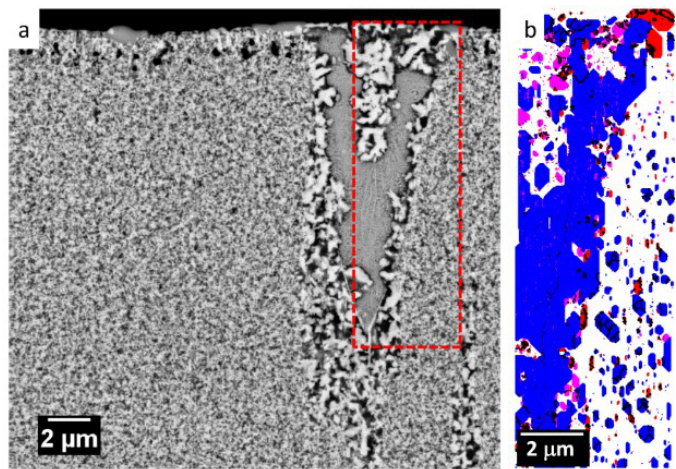
Figure 4. Back scattered electron image ( a ) and Electron Backscatter Diffraction (EBSD) phase map ( b ) of the cross-section of the Fe-24W sample annealed at 800 °C for 1 h. The EBSD phase map is acquired from the red dashed box highlighted in (a). The blue grains belong to α-Fe phase, the red grains to the FeWO 4 phase, and the violet grains are identified as Fe 2 W phase.